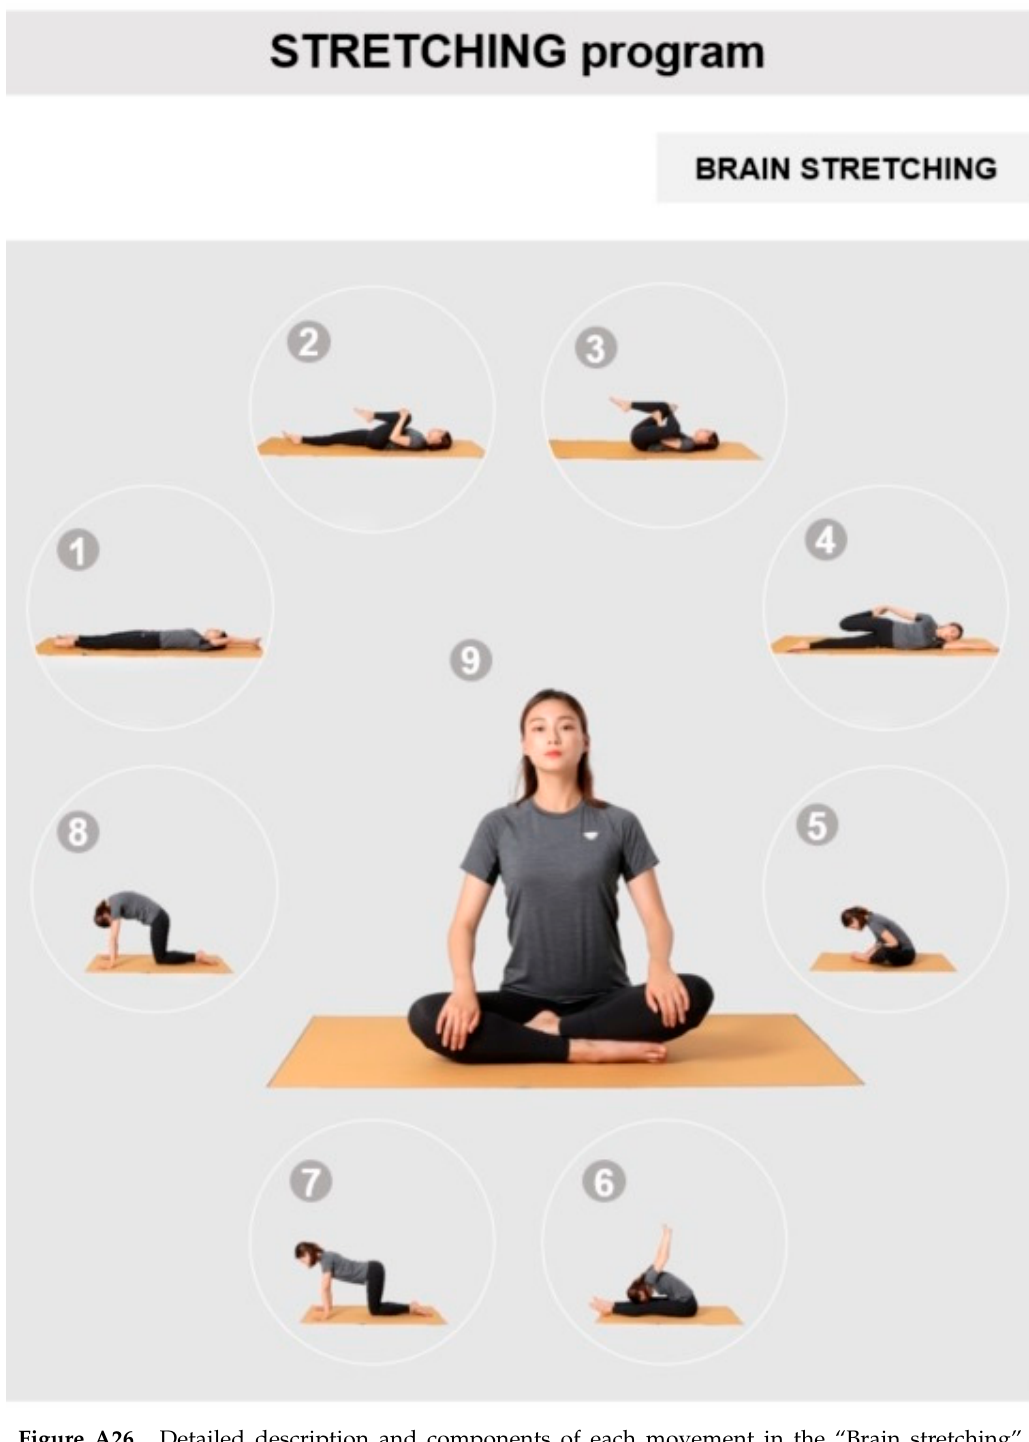
Figure A26. Detailed description and components of each movement in the “Brain stretching” stretch exercise.